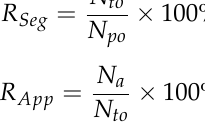
Figure 14. Main interface of the apple image segmentation program.